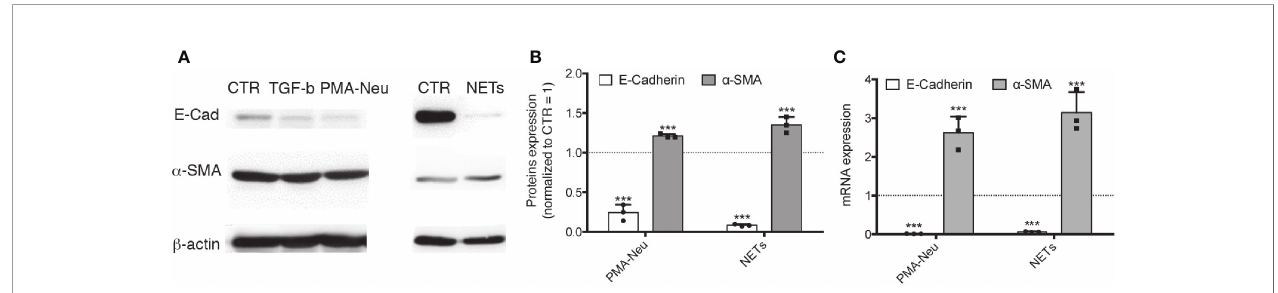
FIGURE 3 | (A) Representative immunoblots of A549 treated with different conditions for 48 h. Membrane was immunodecorated with antibodies speci fi c for E- Cadherin, a -SMA and b -actin. (B) Quanti fi cation of immunoblots of A549 using anti-E-cadherin or anti- a -SMA incubated with 2.5 x 10 6 PMA-Neu or NETs isolated from 2.5 x 10 6 PMA-Neu after 24 h. (C) RT-PCR analysis of RNA extracted by A549 treated with PMA-Neu or NETs for 24 h. Data are represented as mean ± SD of three independent replicates. ***p < 0.001 vs .